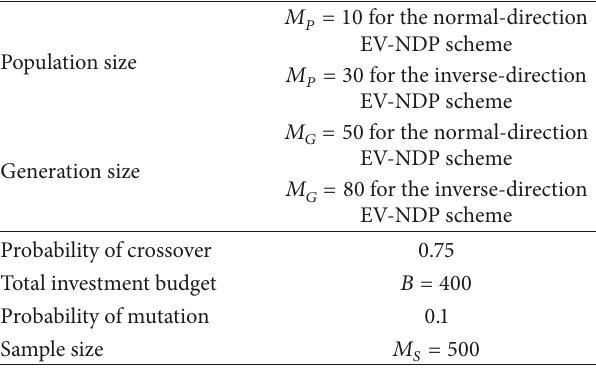
Table 4: Other parameters used in the numerical experiments.